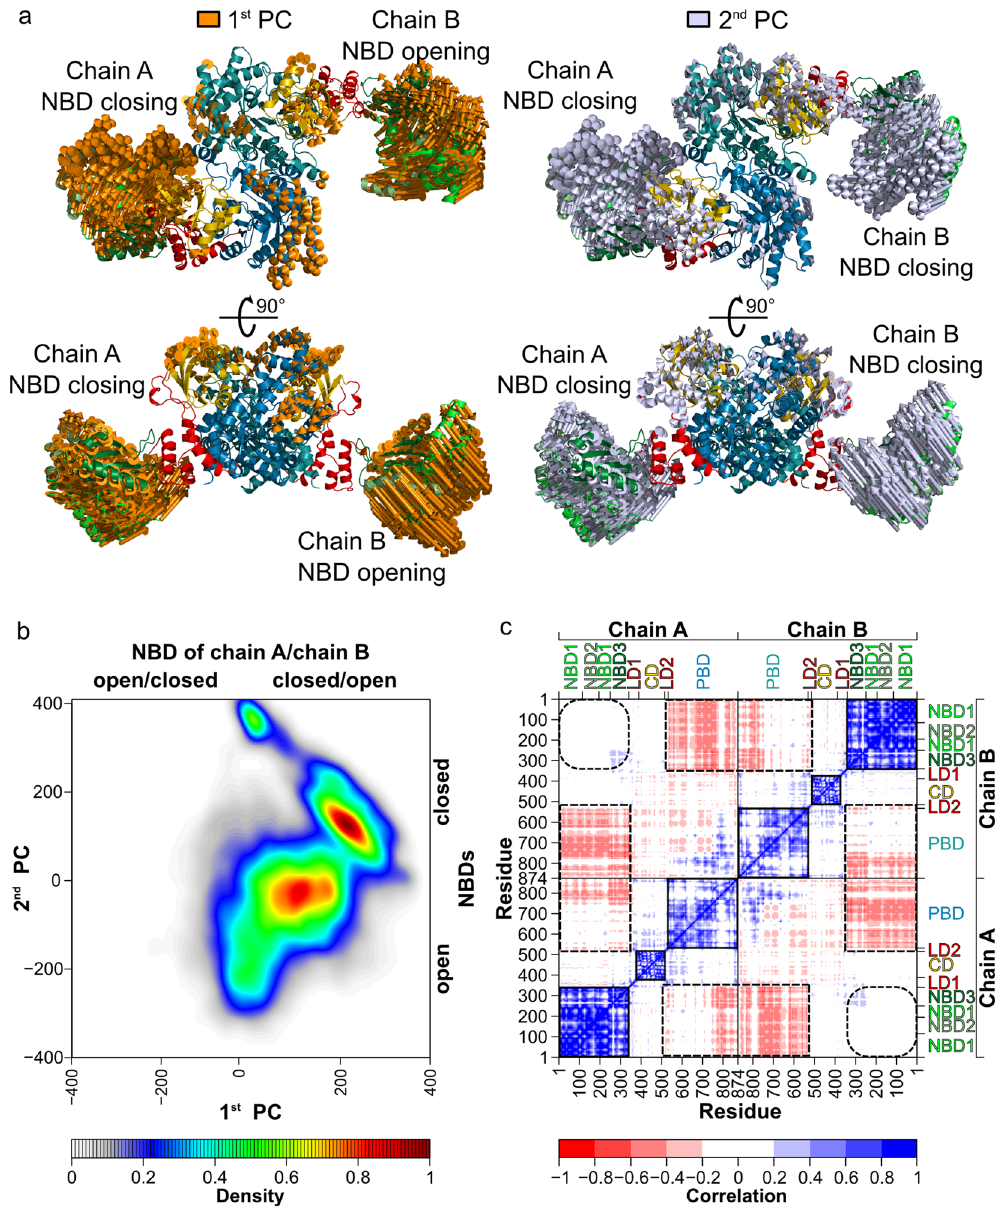
Figure 2. Correlation of motions in the PPDK dimer. ( a ) Representation of atomic displacements along the directions of the 1 st (gold, left) and 2 nd (silver, right) principle component, computed from MD simulations of an aggregate simulation time of 3.6 μ s. The 1 st PC describes an antisymmetric motion of both NBDs (i.e., one opens, the other closes), the 2 nd describes a symmetric one (i.e., both open, or close, simultaneously). The amplitudes of the motions were scaled, and a cutoff for small displacements was applied for best graphical representation. ( b ) Density distribution of conformations from the twelve MD simulations mapped onto the plane spanned by the 1 st and 2 nd PCs. The highest density has been normalized to 1, and all other densities accordingly. (c) Cross-correlation map of C α atom fluctuations from MD simulations with the residue numbering labeled on the left and at the bottom, and the substructures labeled on the right and top axes. Positive correlations are indicated in blue, negative correlations in red (see color scale). Correlated motions within and between domains are marked with squares with solid and dashed lines, respectively. Squares with round corners indicate that no correlated motions between the two NBDs were